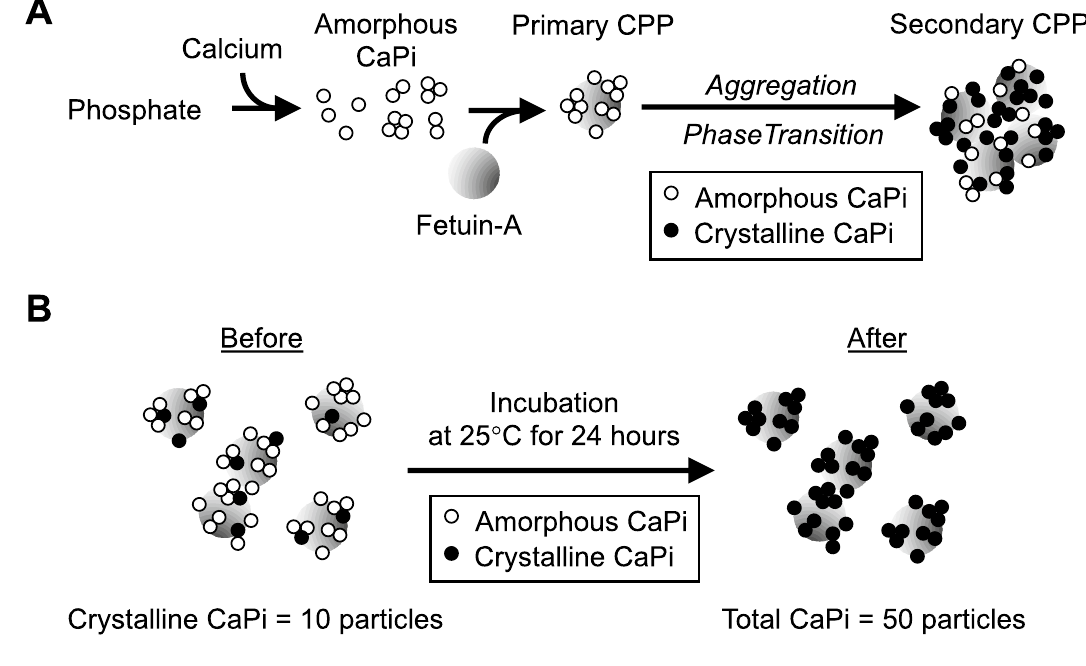
Figure 1. Calciprotein particles (CPPs) with different properties. ( A ) A schematic representation of CPP formation and maturation. Precipitates of amorphous CaPi (open circles) are adsorbed by fetuin-A protein (grey circles) to form primary CPPs. Primary CPPs undergo aggregation and transition of CaPi from the amorphous phase to the crystalline phase to become secondary CPPs. ( B ) A schematic representation of estimation of the amorphous CaPi ratio. Incubation at 25 °C for 24 h induces amorphous-to-crystalline phase transition of CaPi. Because the gel filtration assay can measure crystalline CaPi but not amorphous CaPi, the amorphous CaPi amount (40; the number of open circles) can be estimated as the difference in the number of closed circles between before (10) and after (50) the